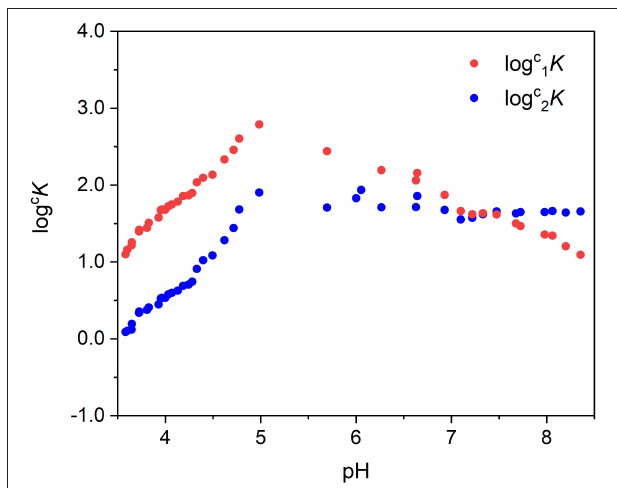
FIGURE 8 | Values of log c n K as a function of pH (some experimental points corresponding to the curve inflection were